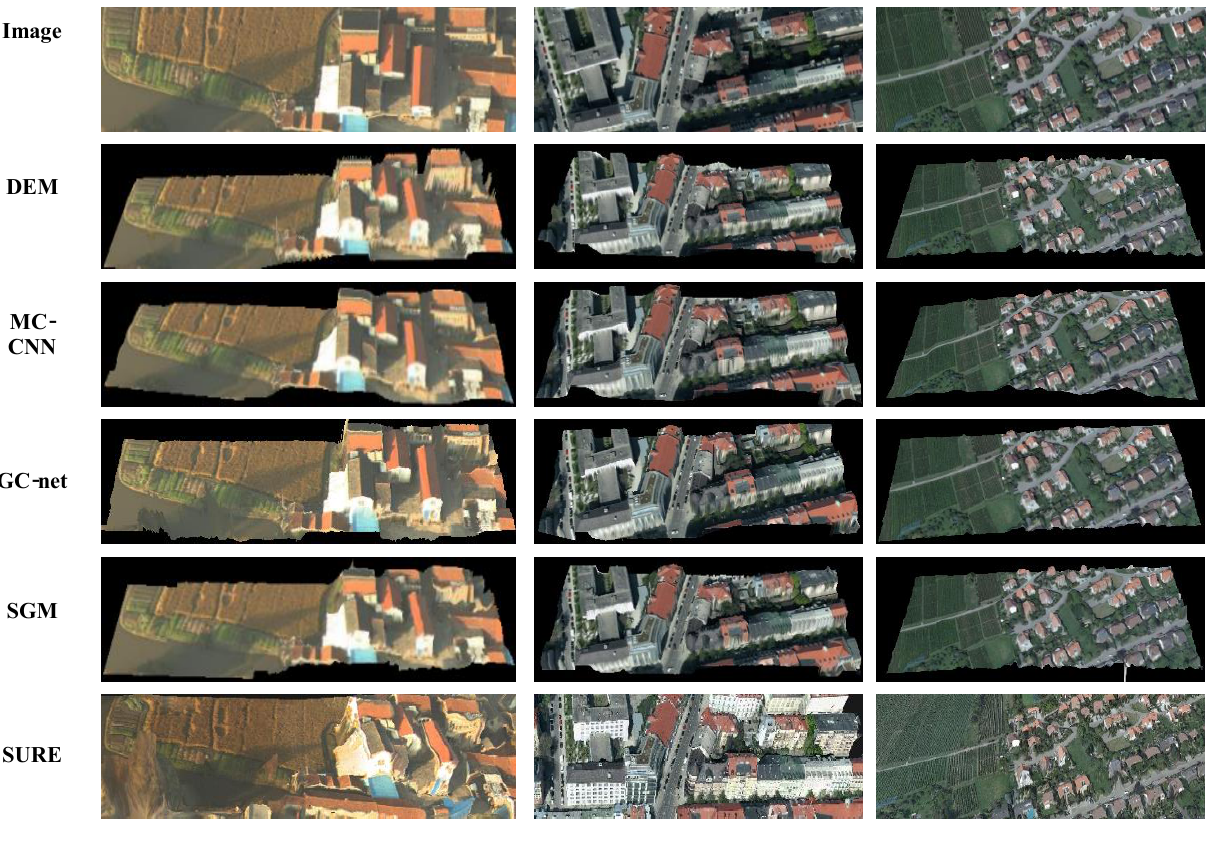
Figure 1. 3D scene recovered from dense disparity